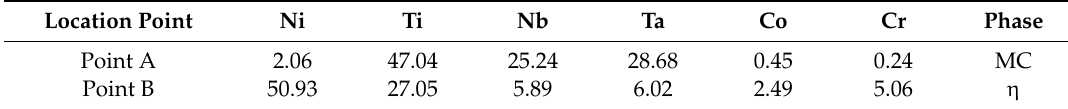
Figure 6. Microstructure of the BM under casting conditions; ( a ) dendrite morphology of the as-cast BM, ( b ) MC carbide precipitated at the grain boundaries, ( c ) MC and η phases and ( d ) γ ´ precipitates. Table 3. Chemical analysis (wt. %) illustrated in Figure 5c.